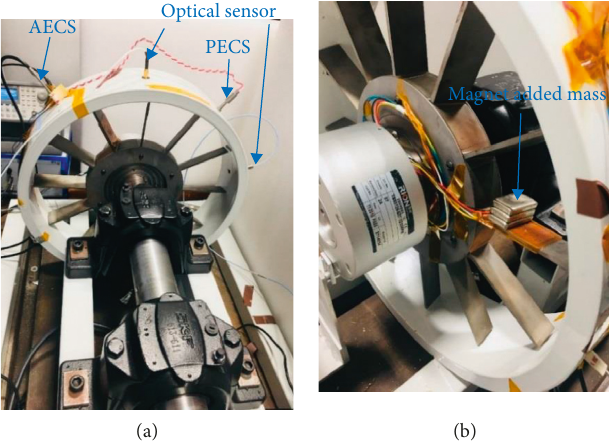
Figure 7: (a) BTT experimental test rig; (b) blade with magnet added mass.